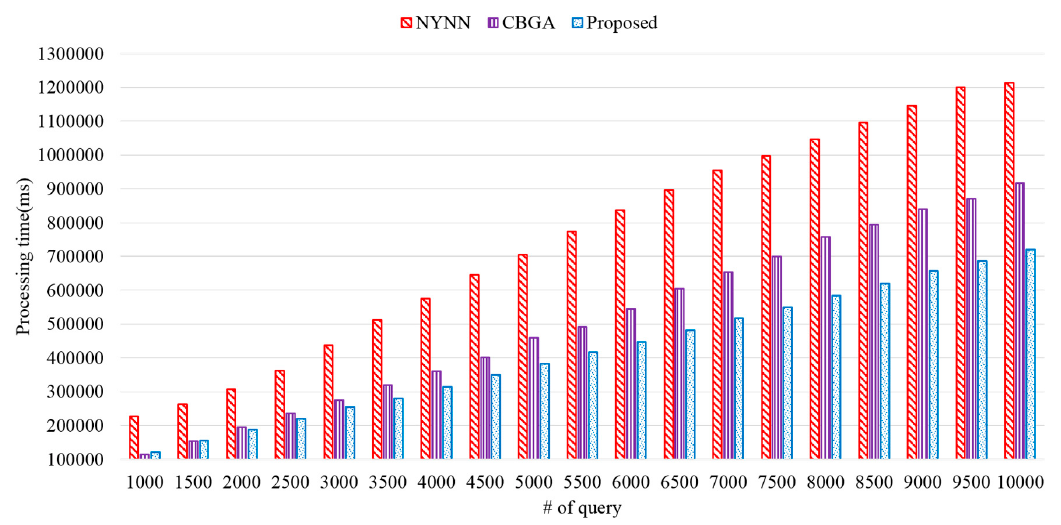
Figure 12. Processing time according to data request.